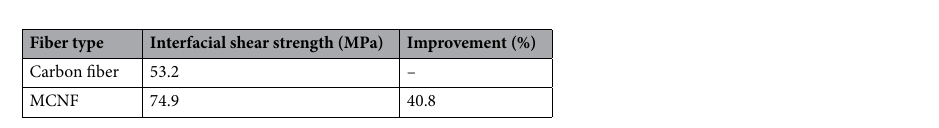
Table 5. IFSS of various single fibers droplet